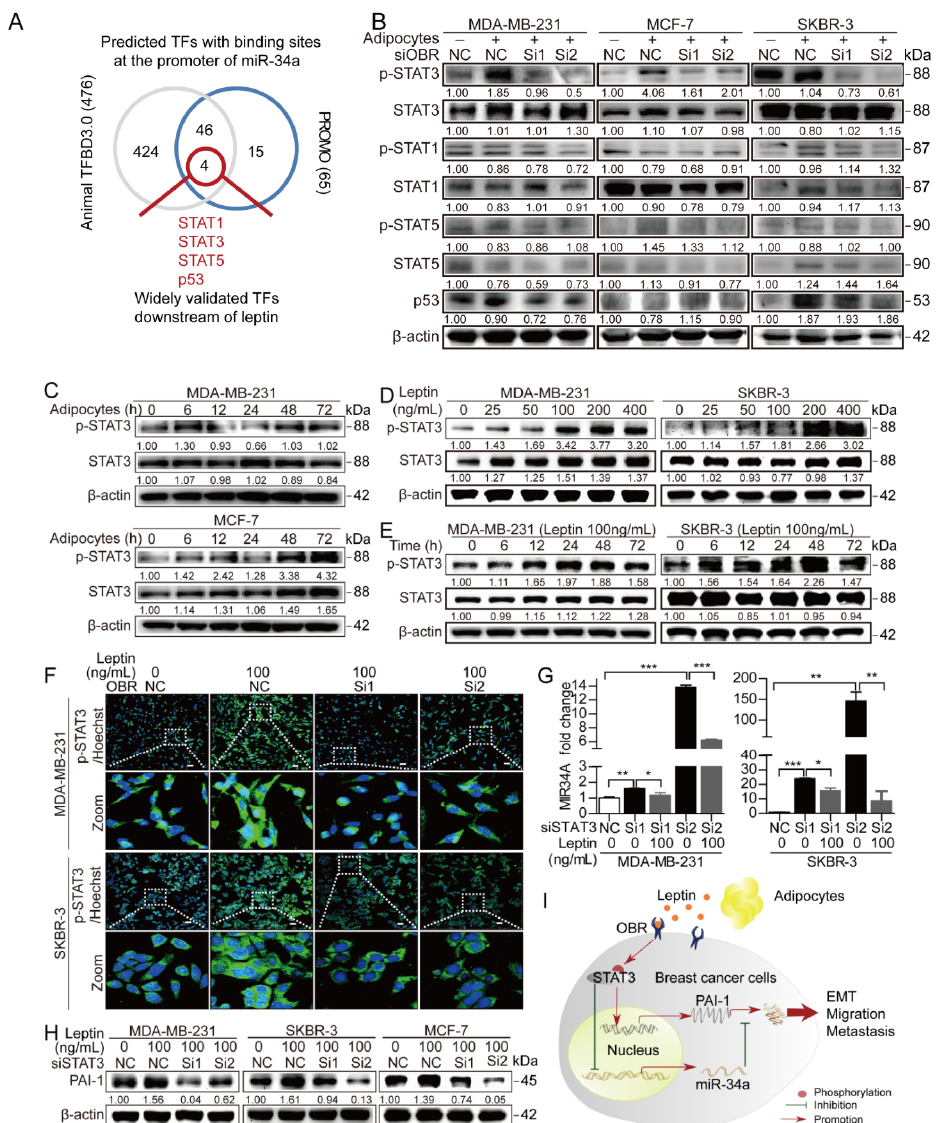
Figure 8. STAT3 is involved in leptin/OBR-induced miR-34a suppression and PAI-1 activation. ( A ) Prediction of TFs with binding sites at the miR-34a promoter. ( B ) Cancer cells were transfected with OBR-specific siRNA or NC siRNA followed by culture ± adipocytes for 72 h, and then western blotting was performed. ( C ) Cancer cells were cocultured with adipocytes for the indicated time points followed by western blotting. ( D , E ) After stimulation with leptin (0–400 ng/mL for 24 h or 100 ng/mL for 0–72 h), cancer cells were collected for western blotting. ( F ) Immunofluorescence for p- STAT3 in cancer cells after transfection with OBR-specific siRNA or NC siRNA followed by leptin treatment (100 ng/mL, 72 h). Scale bar=100 μ m. ( G ) After transfection with STAT3-specific siRNA, cancer cells were treated with leptin (100 ng/mL, 24 h) and then collected for qRT-PCR. Bars indicate means ± SEMsfrom three independent experiments, * p < 0.05, ** p < 0.01, *** p < 0.001. ( H ) STAT3- specific siRNA or NC siRNA was transfected into cancer cells followed by exposure to leptin (100 ng/mL, 24 h), and thenwestern blotting was performed. ( I ) Schematic diagram of the proposed mechanisms whereby adipocytes induced metastasis of breast cancer cells.